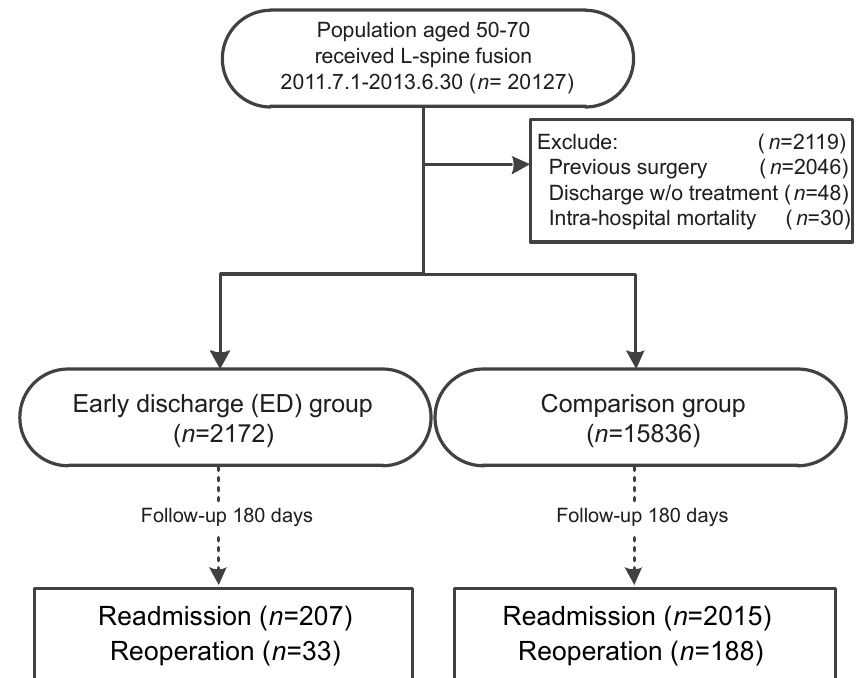
Figure 1. Flowchart of data processing in a cohort of patients who received first lumbar spinal fusion surgery. Patients were grouped into two: the early discharge (ED) group and the comparison group. Initial patients may have met one or more exclusion criteria; therefore, the total number exceeded the number of included patients ( n = 18,008).